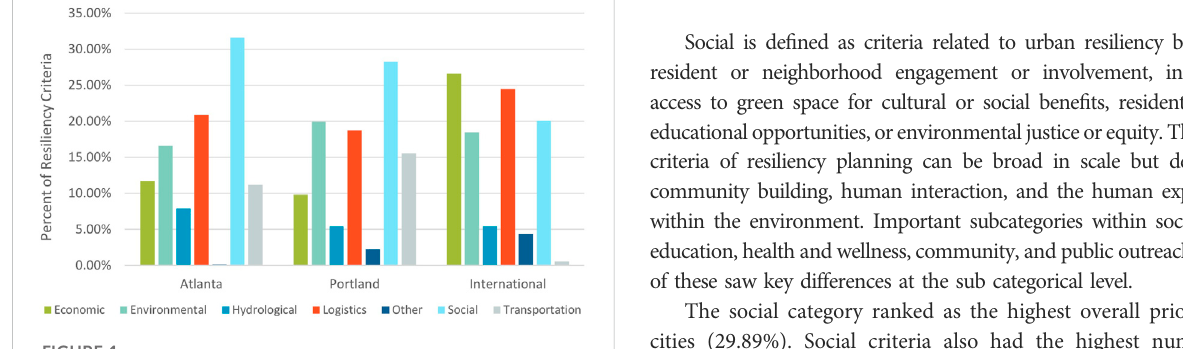
FIGURE 1 Initial criteria fi ndings and comparison between US cities and international comprehensive resiliency